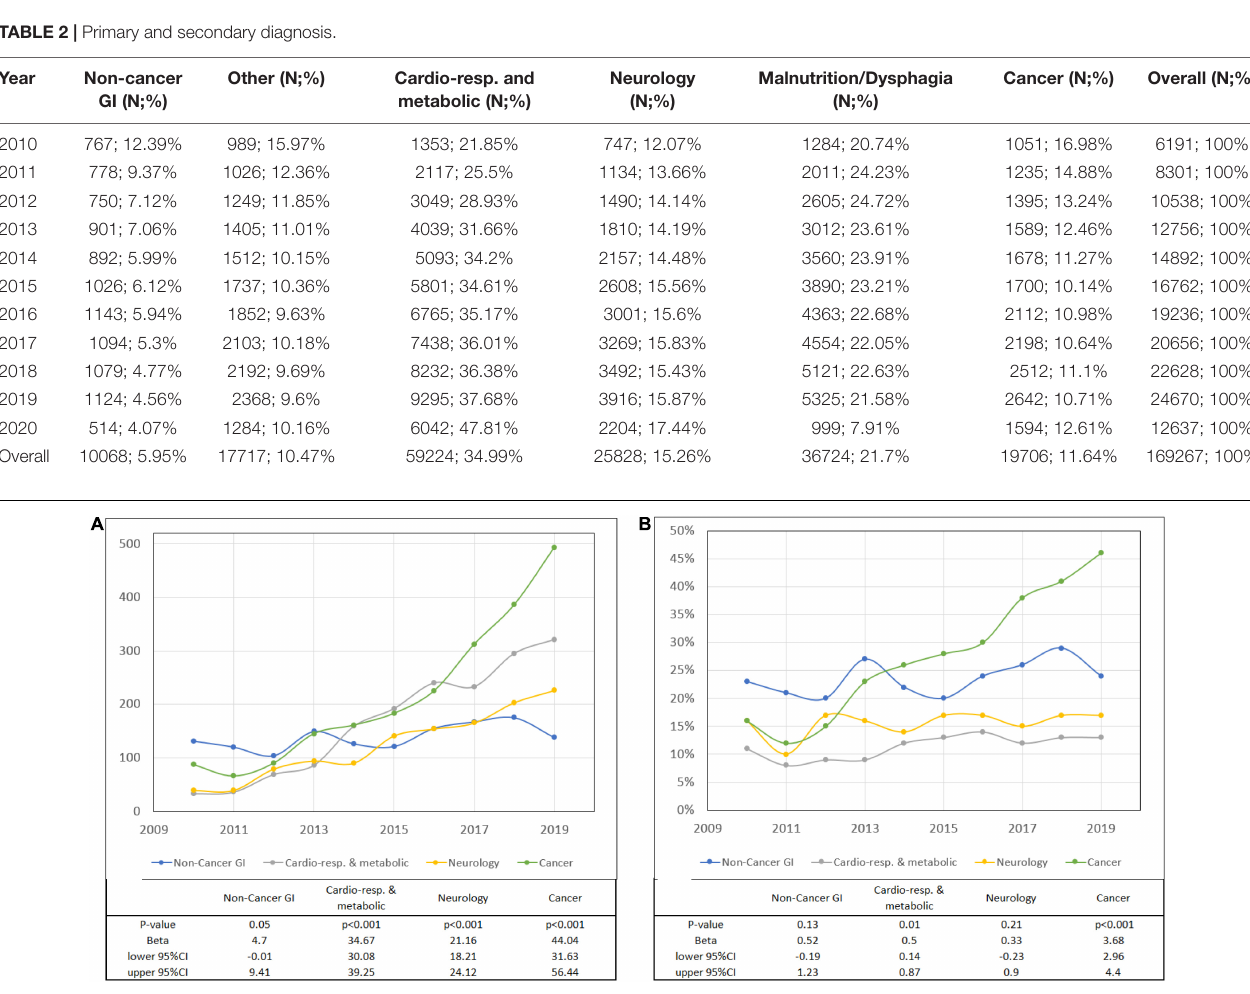
FIGURE 2 | Patients with gastrostomies on home enteral nutrition (HEN) (primary diagnosis). (A) Number and (B) the percentage of PEGs according to the primary diagnosis.